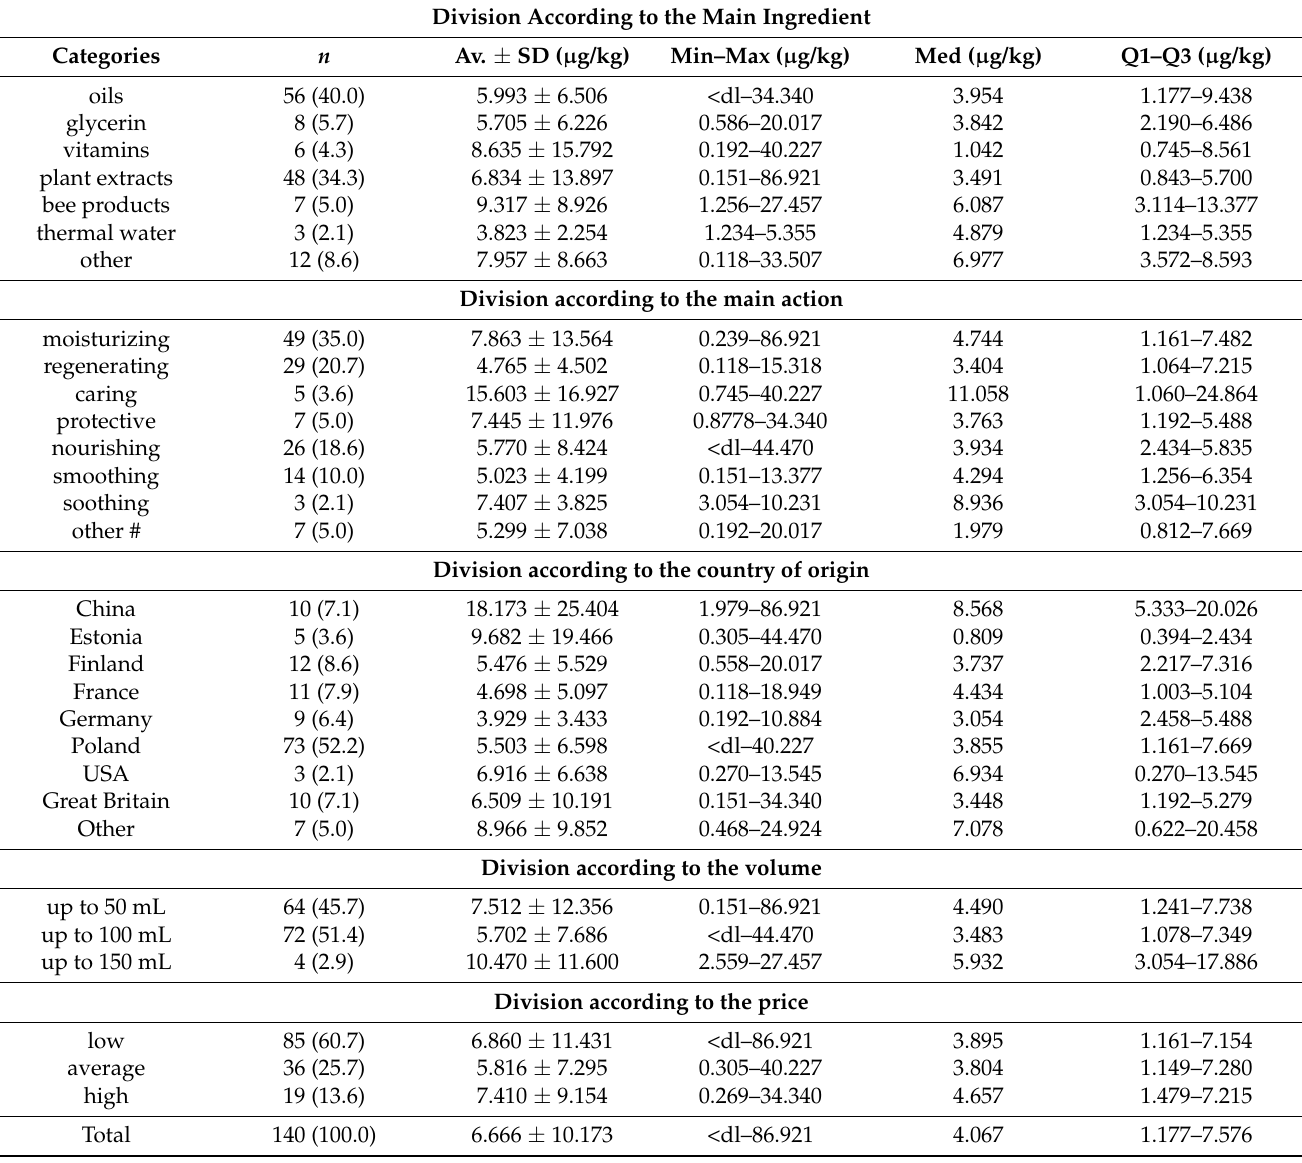
Table 2. Hg content in different categories of hand